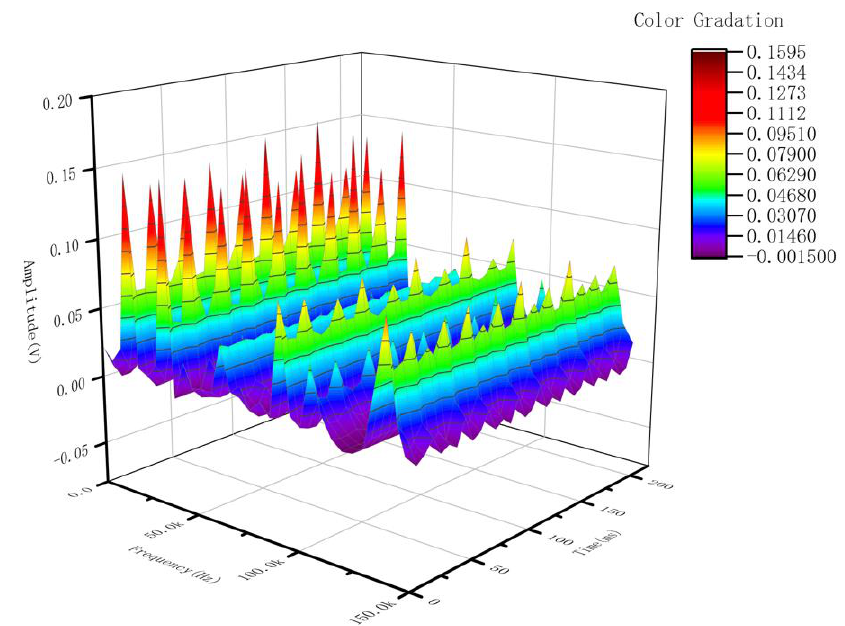
Figure 7. Class D signal test experimental results.